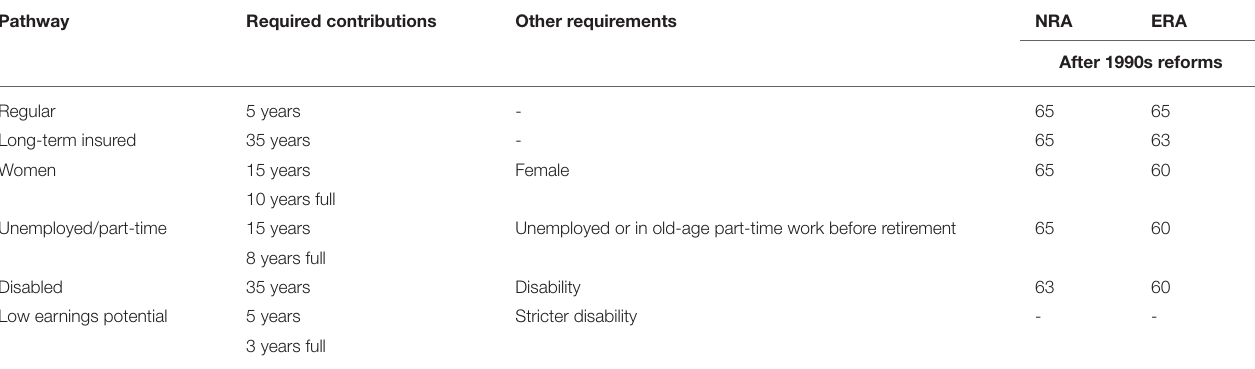
TABLE 3 | Pathways to Retirement in Germany.